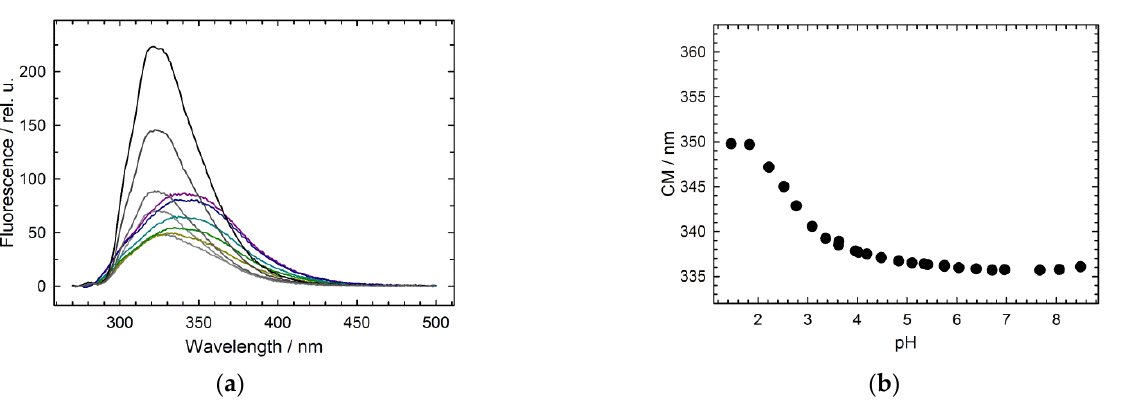
Figure 7. The pH dependence of Hfq Y55W fluorescence spectrum. ( a ) Fluorescence spectra measured at pH 6.0, 5.07, 4.15, 3.53, 3.03 (lines range from black to light grey); 2.72, 2.16, 1.76, 1.6, 1.4 (dark yellow, green, light blue, dark blue, and purple lines, respectively). Protein (monomer) concentration is 67 μ M. ( b ) The pH dependence of the spectrum center of mass (CM). For different pH values, the following buffer solutions were used: 20 mM Tris-HCl, 30 mM NaCl for pH 7.6–8.5; 20 mM Na-Cacodylate-HCl, 30 mM NaCl for pH 5.35–6.93; 20 mM Na-Acetate, 30 mM NaCl for pH 3.55–5.65; 20 mM Glycine-HCl, 30 mM NaCl for pH 2.16–3.83; 20 mM HCl, 30 mM NaCl for pH 1.76; 50 mM HCl for pH 1.4.